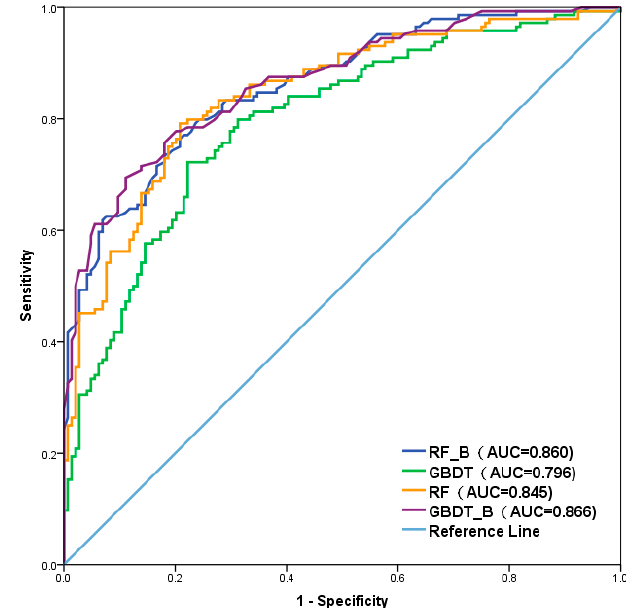
Figure 8. The ROC curve of the four